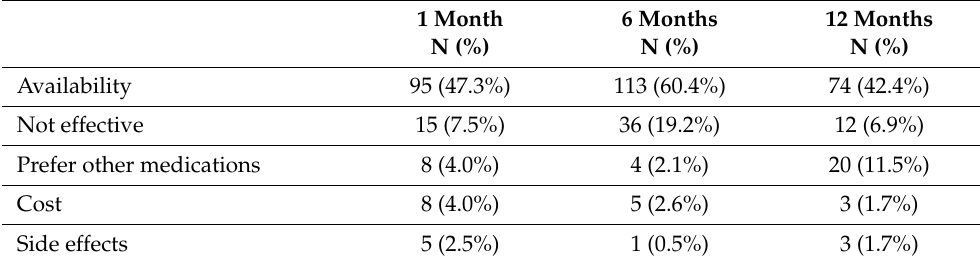
Table 6. Reasons for discontinuation of a MC